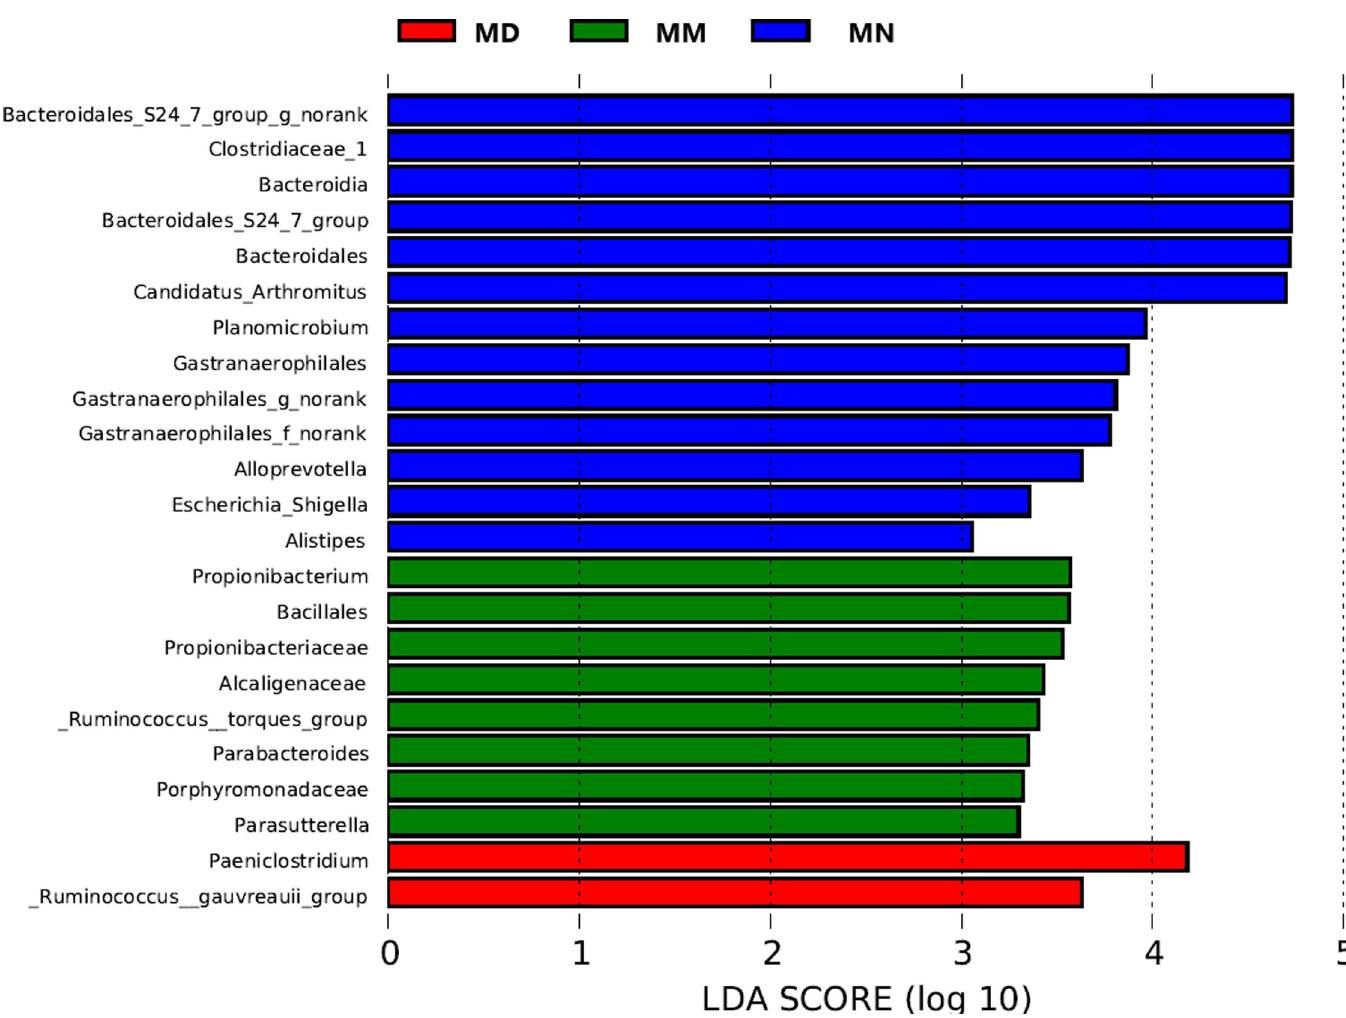
Fig 6. Histogram of the Linear discriminant analysis. Histogram of the Linear discriminant analysis (LDA) coupled with effect size measurements (LEfSe) identified the most differentially abundant genera between the MN, MM and MD groups.